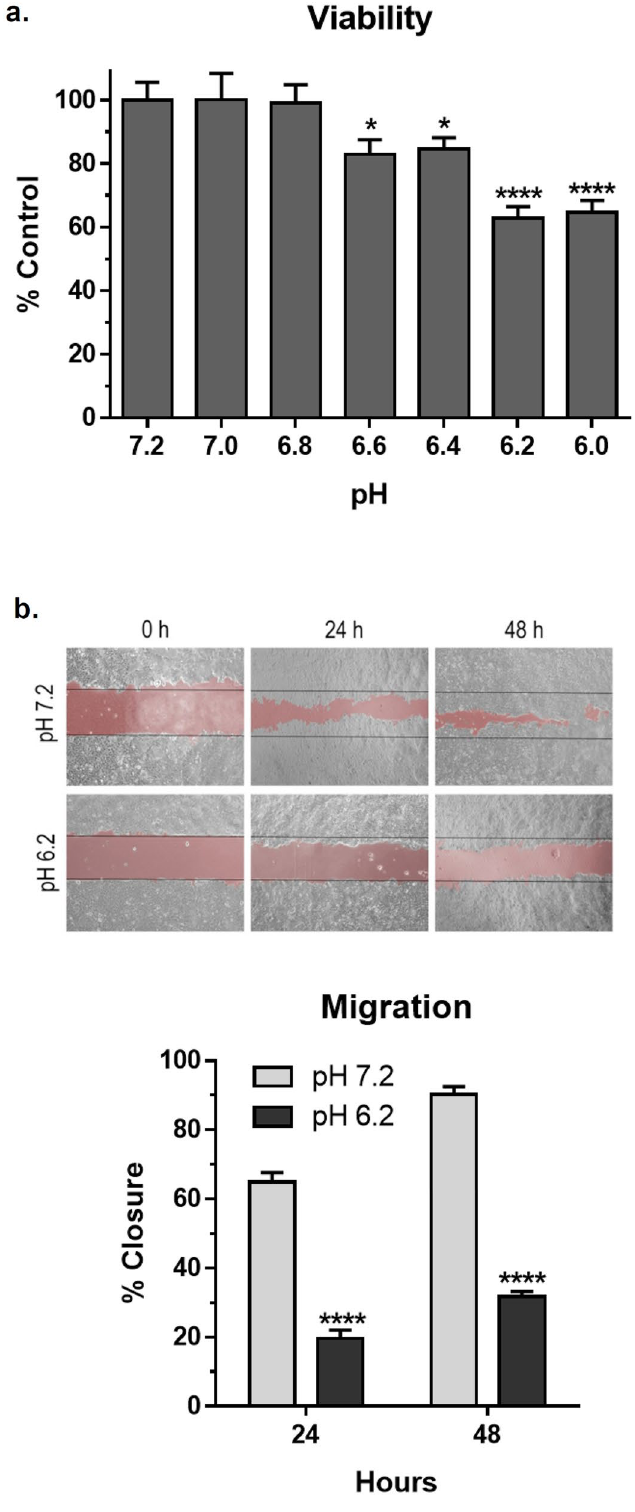
Figure 1. Acidic pH decreases MCF 7 mammary carcinoma cell viability and proliferation. ( a ) Cell viability was examined by MTT assay after 24 h growth at indicated pH. Data are shown as percent of control cells grown at pH 7.2 (mean + SEM, n = 8). Single and quadruple asterisks indicated p < 0.05 and p < 0.0001 compared to control cells by t-test, respectively. ( b ) Cell migration was evaluated by wound healing during 24 and 48 h growth at pH 7.2 or pH 6.2. Phase-contrast images are presented along with data shown as the percent of the wound that was filled by cells (mean + SEM, n = 4) with quadruple asterisks indicating p < 0.0001 by